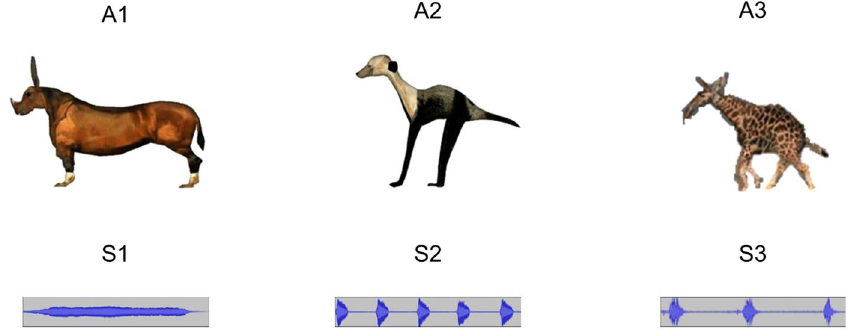
Figure 1. Stimuli. Three novel animals and unfamiliar sounds used in the present study. The animals were created and animated using the Animation:Master software (Hash,